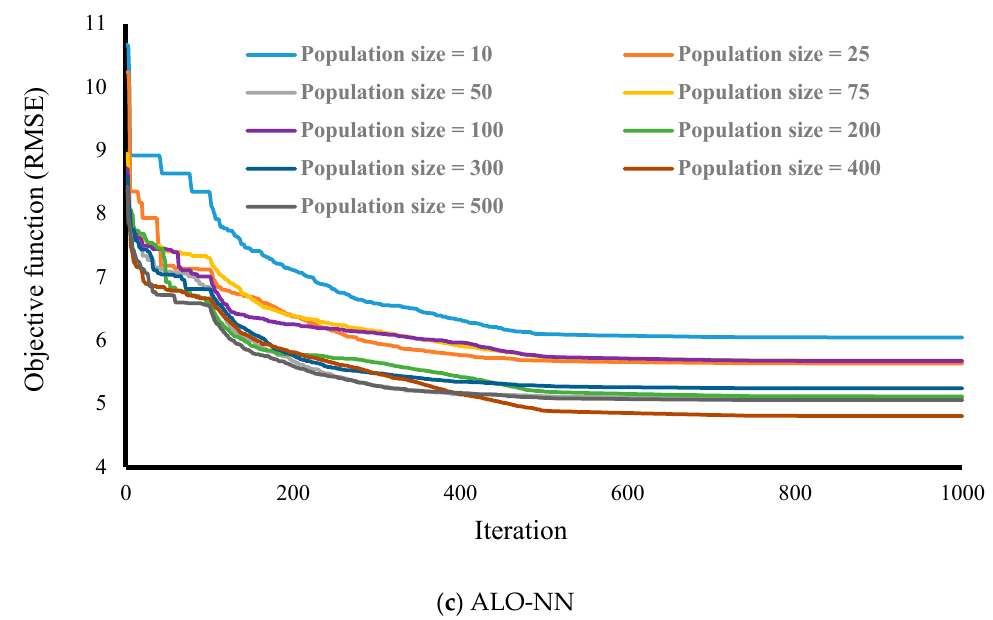
Figure 5. The sensitivity analysis based on the model complexity for the ( a ) BBO-NN, ( b ) GOA-NN, and ( c ) ALO-NN.